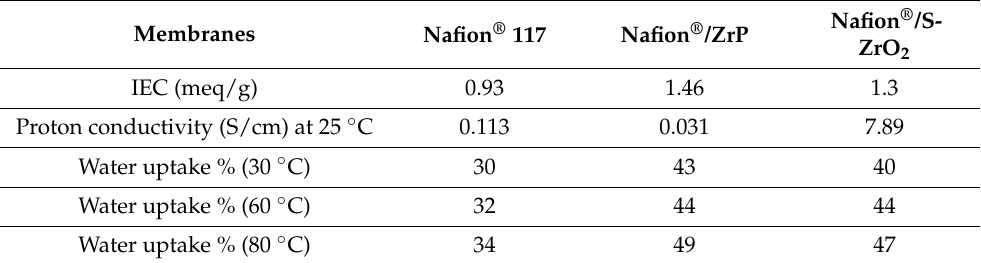
Figure 7. The methanol permeability of Nafion ® 117 membrane and Nafion ® /ZrP and Nafion ® /ZrO 2 nanocomposite membranes at 5 M and 2 M concentration. Table 2. The proton conductivity and IEC of Nafion ® 117 membrane and Nafion ® /ZrP and Nafion ® /S-ZrO 2 nanocomposite